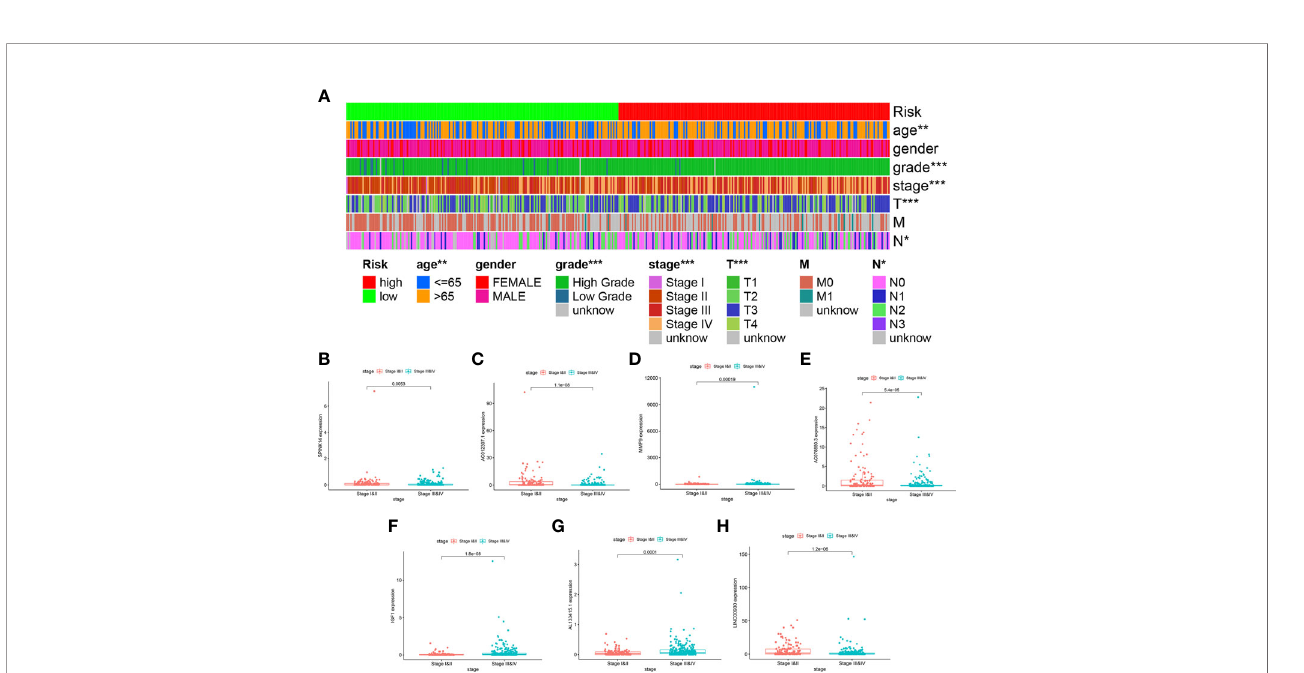
FIGURE 9 | Stage correlation of the risk score and 11 hub genes in the signature. (A) Multifactorial heatmap showing certain clinical features with a signi fi cant correlation with the risk score. (* p < 0.05, ** p < 0.01, *** p < 0.001) (B – H) . The expression of IGF1 and AL133415.1 were positively correlated with TNM stages, while the expression of SPINK14, MMP9, AC078880.3, LINC00930, and AC012307.1 were negatively associated with the TNM